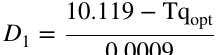
Table 3 Maximum recommended WOB by Estes (Eren and Ozbayoglu 2010)